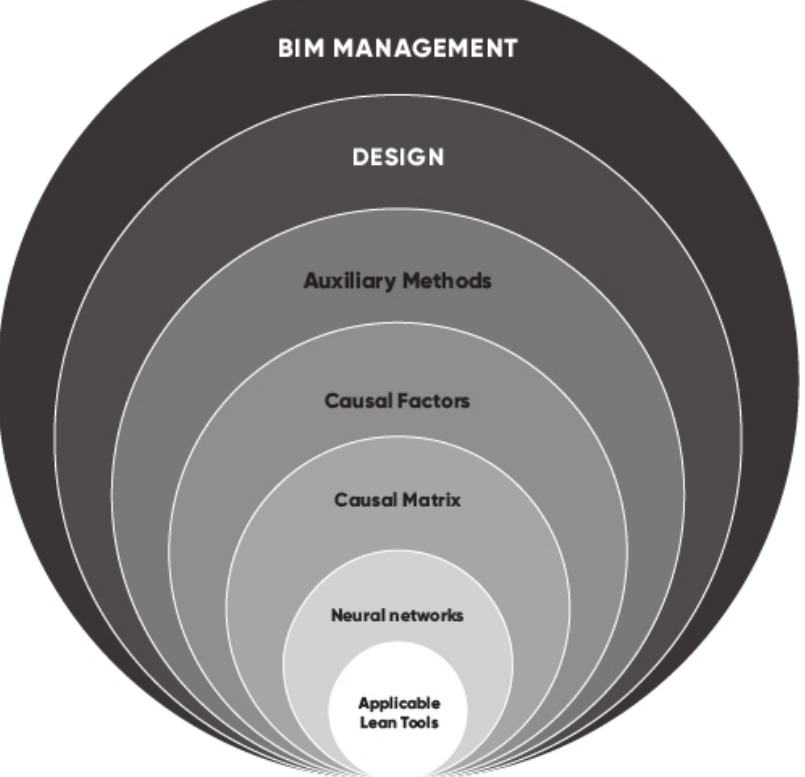
Figure 9. Method